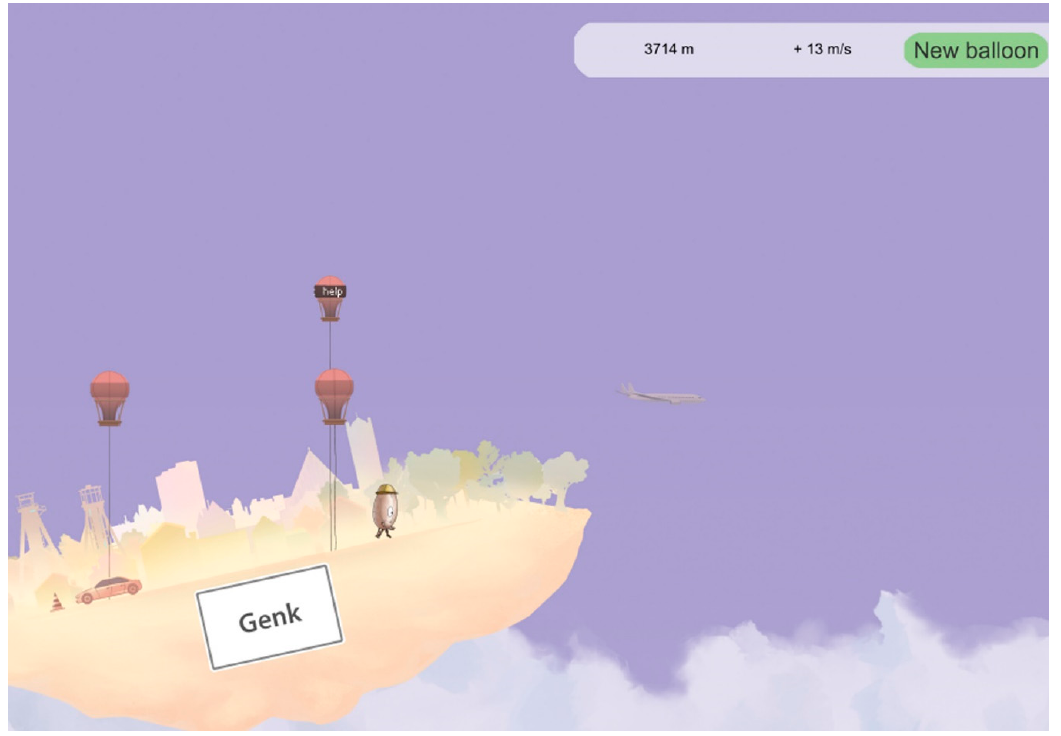
Figure 4. Floating City.